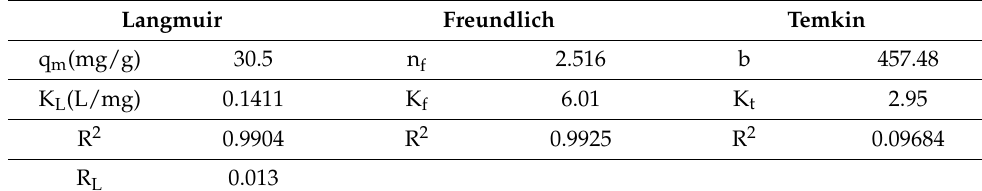
Table 3. Model parameters for adsorption isotherm study of adsorption CV by LCF.